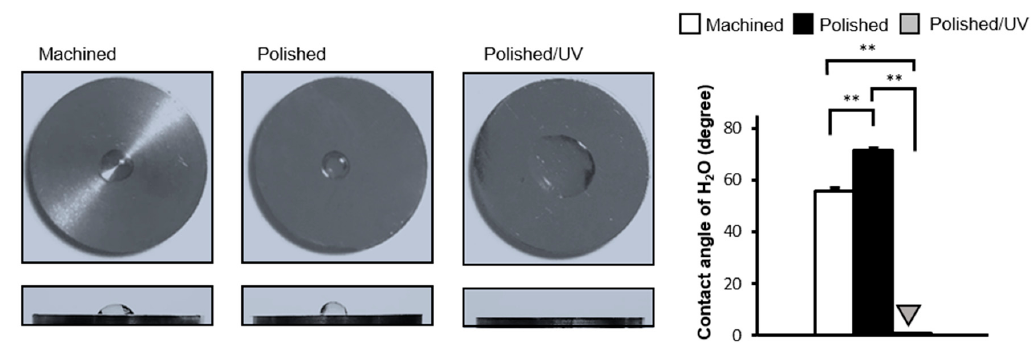
Figure 3. Hydrophobicity / hydrophilicity status of titanium surfaces. Contact angles for 10 µ L sterile ultra-pure water (ddH 2 O) on various titanium disks (** p < 0.01).